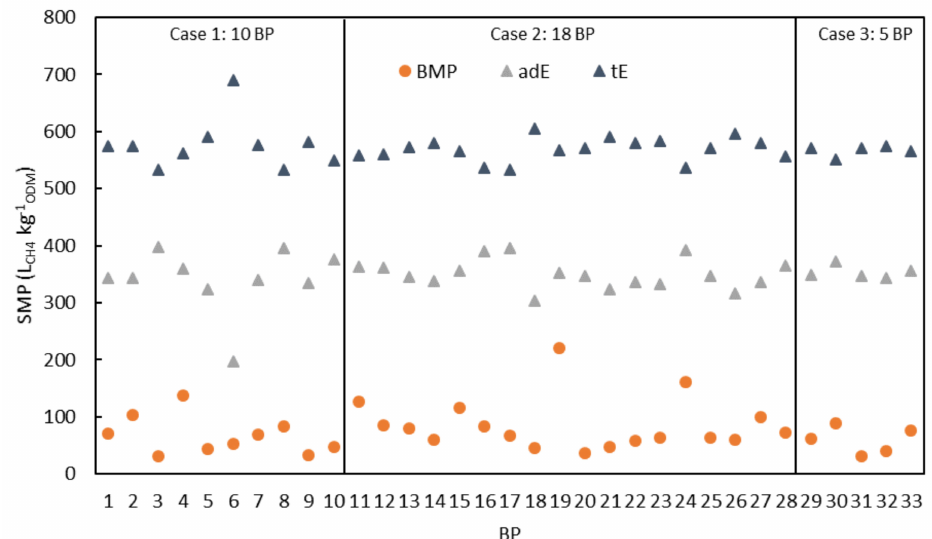
Figure 4. The spec. methane potential of digestate (SMP) of 33 biogas plants (BP) determined by biochemical methane potential test (BMP), anaerobically degradable energy (adE) and total energy (tE), based on the ODM in